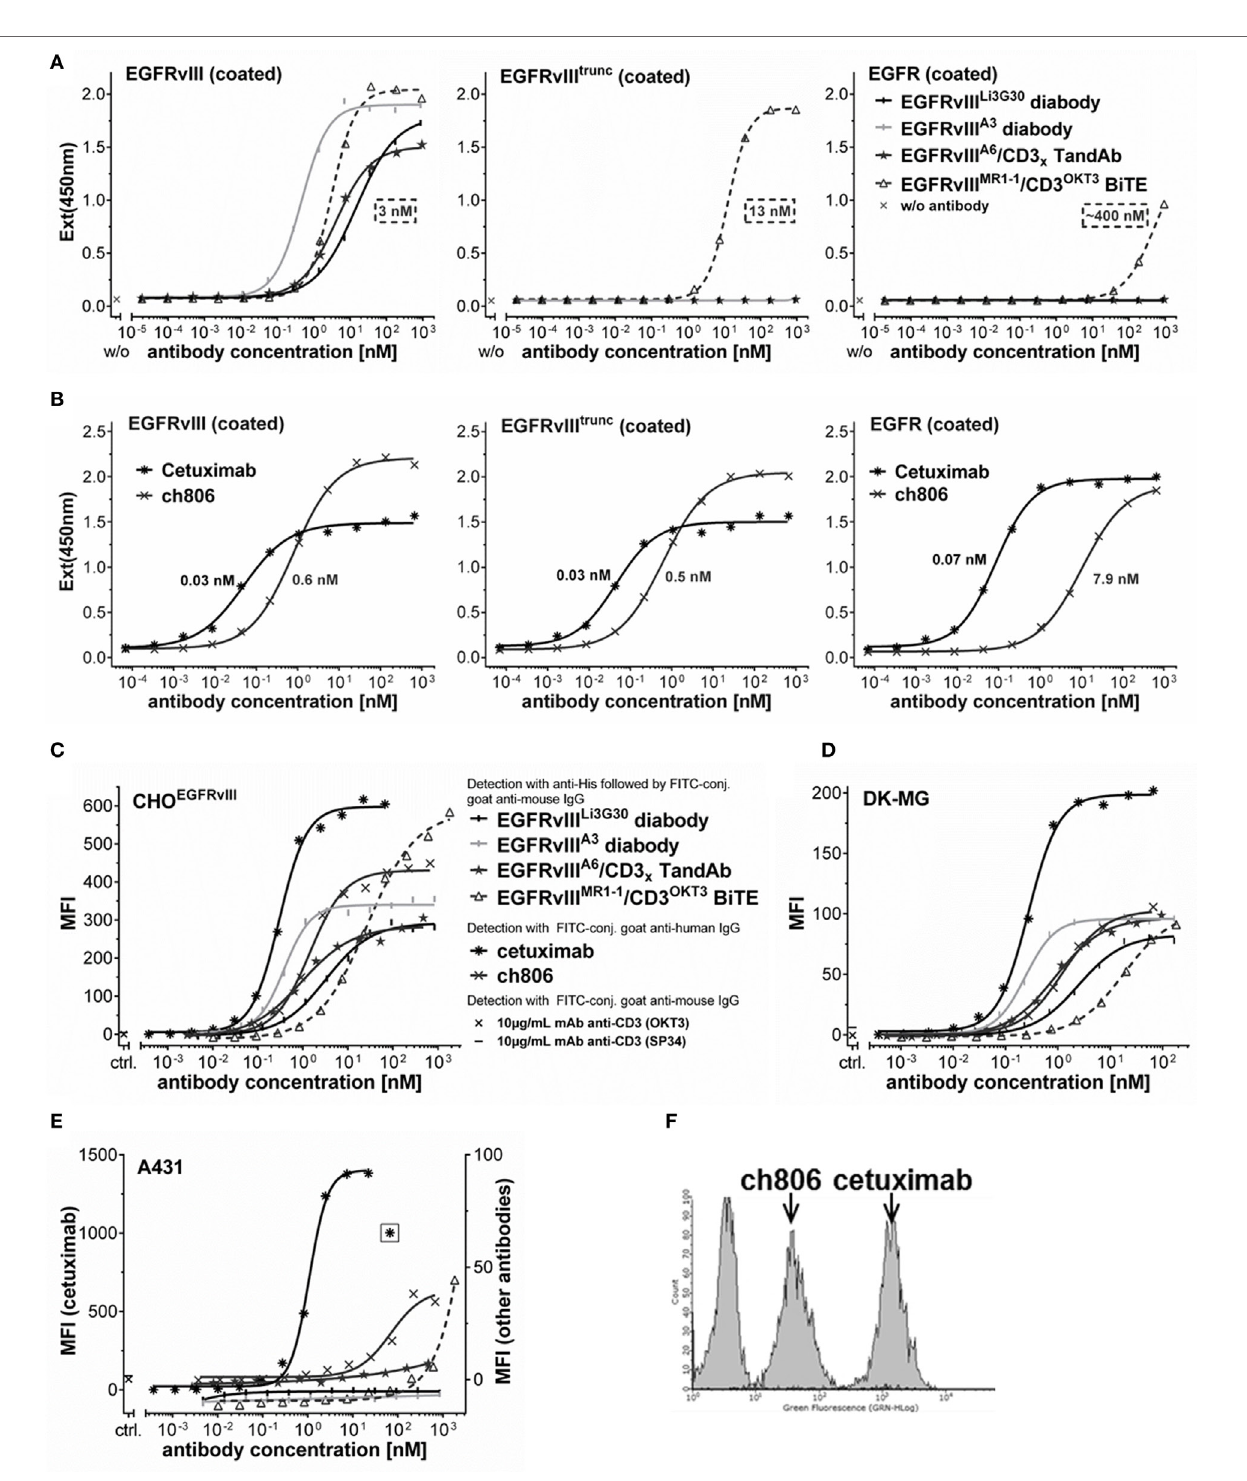
FigUre 3 | Binding affinity and specificity for egFrviii antigen and on cells . (a,B) Concentration-dependent binding of different His-tagged antibody fragments (a) or monoclonal antibodies (B) to recombinant EGFRvIII-Fc, EGFRvIII trunc -Fc, or EGFR-Fc coated in ELISA. K D values indicated in the graphs were calculated with the equation one site binding (hyperbola), least squares (ordinary) fit using GraphPad Prism. (c–e) Concentration-dependent cell binding of different antibody constructs analyzed by sigmoidal dose–response/four parameter logistic fit: (c) CHO cells stably transfected to overexpress EGFRvIII, (D) DK-MG cells expressing EGFRvIII and EGFR, (e) A431 cells overexpressing EGFR (cetuximab staining signals on A431 cells due to high intensity are plotted on the separate left axis, signals of all other antibodies are plotted on the right axis with different scale). (F) FACS histogram overlay of A431 cells stained with saturating concentrations of ch806 or cetuximab or detection antibodies alone. MFI, mean fluorescence intensity, ctrl., control antibody staining at single dose of 10 µg/mL.